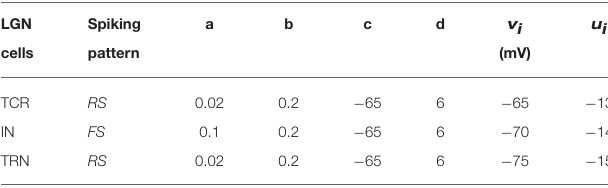
TABLE 2 | The base parameter values for Izhikevich’s neuron model used in the LGN network to produce spiking dynamics shown in Figure 2